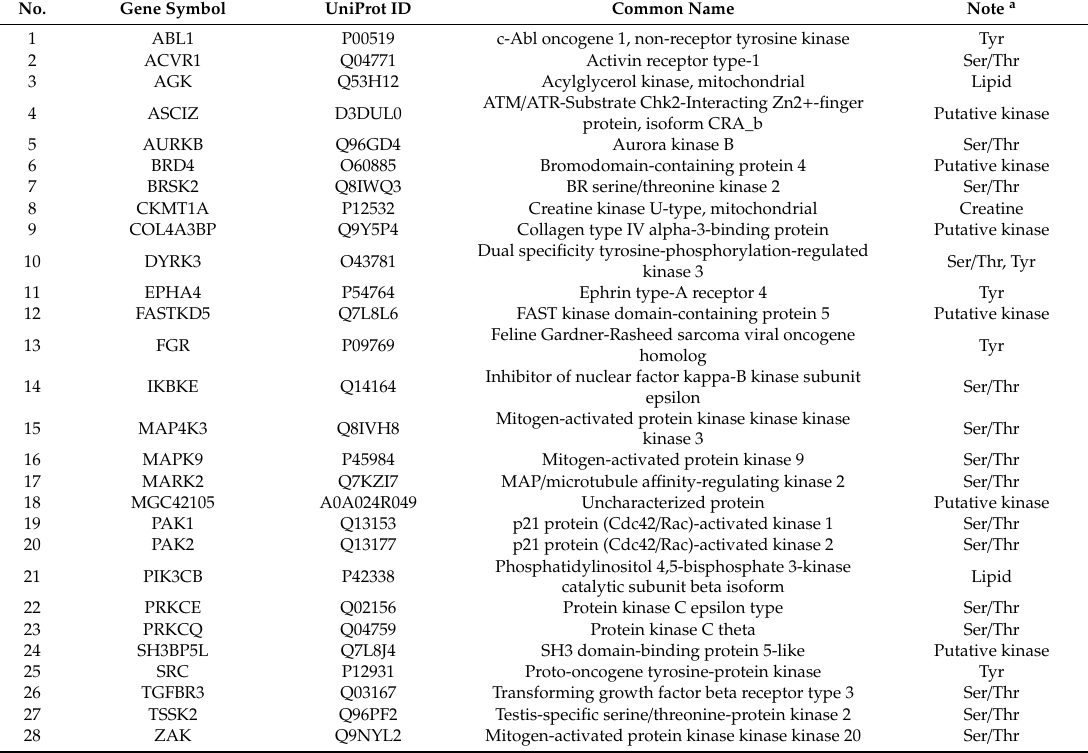
Figure 1. Overexpression of selected kinase genes induces toxicity in yeast. In total, 597 kinase open reading frames (ORFs) were cloned under the control of a galactose-inducible promoter in pAG425 vectors. Empty vector or pAG425GAL-kinases were individually transformed into yeast (BY4742 wild-type strain) and transformants were spotted onto SD-Leu agar plates (kinase expression “off”) or SGal-Leu agar plates (kinase expression “on”). Shown are tenfold serial dilutions starting with an equal number of cells expressing the 28 toxic kinase genes. Non-toxic kinase genes are not shown. Table 1. List of human kinase genes that induce strong toxicity in yeast.